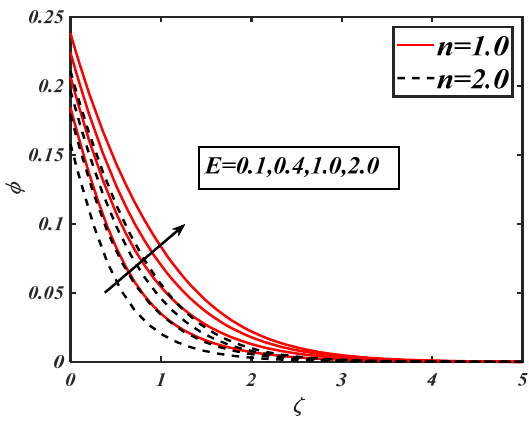
φ . Figure 18. E illustration against φ . φ .